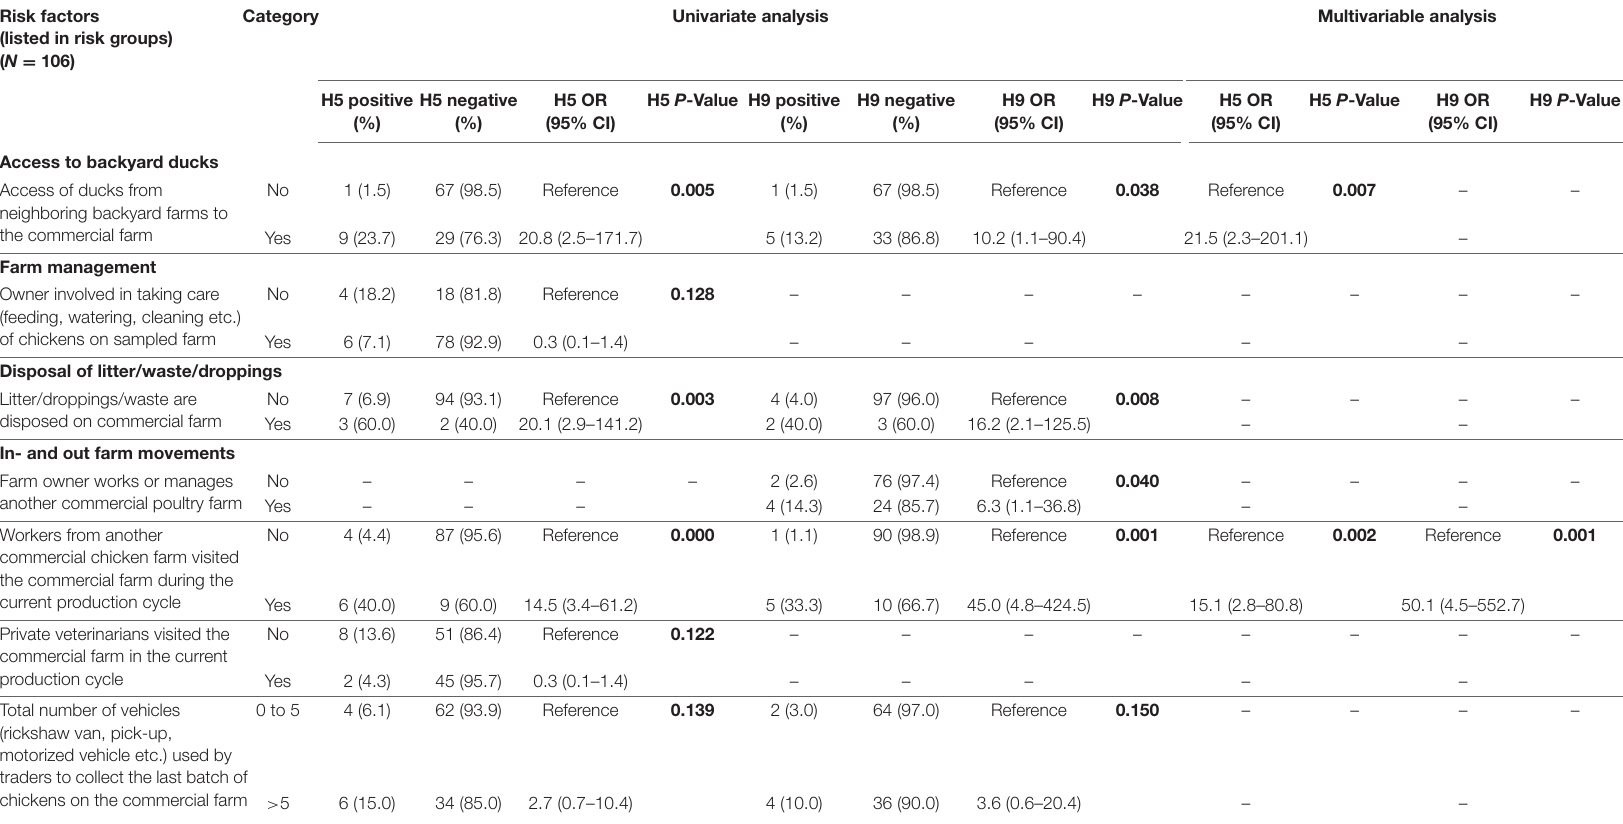
TABLE 1 | Results of the univariate and multivariable analysis of farm-level risk factors associated with H5 and H9 flock-level seroprevalence on broiler farms in Bangladesh, 2017. Risk factors Category Univariate analysis Multivariable (listed in risk groups) ( N = 106)